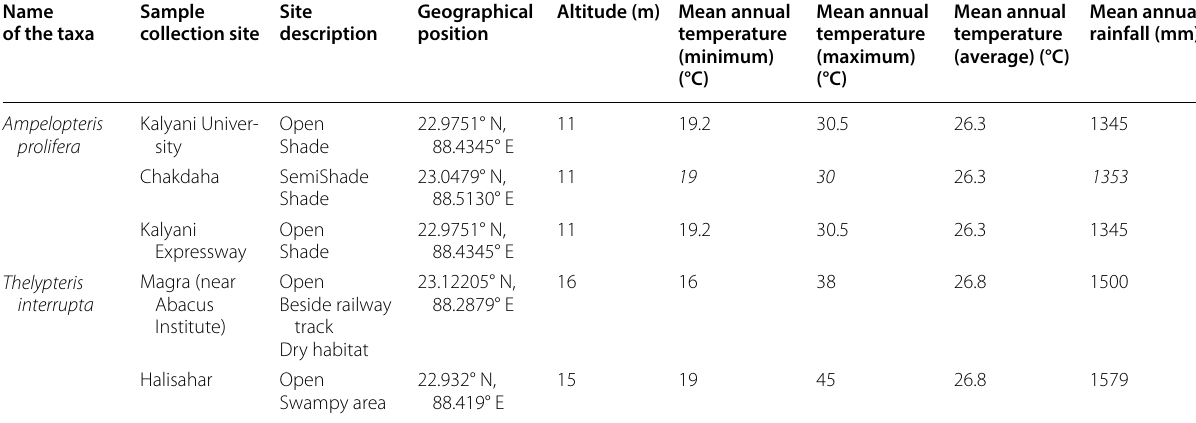
Table 1 Geographical position and climatological data of sampling sites Name of the